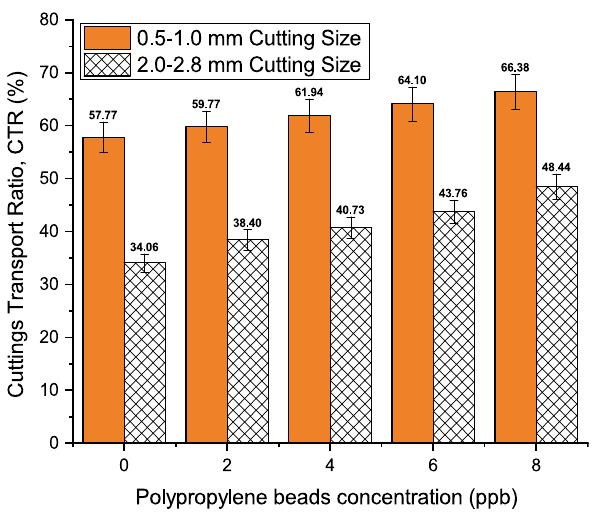
Fig. 8 CTR versus polypropylene bead concentration for both cut- tings sizes with pipe rotation (120